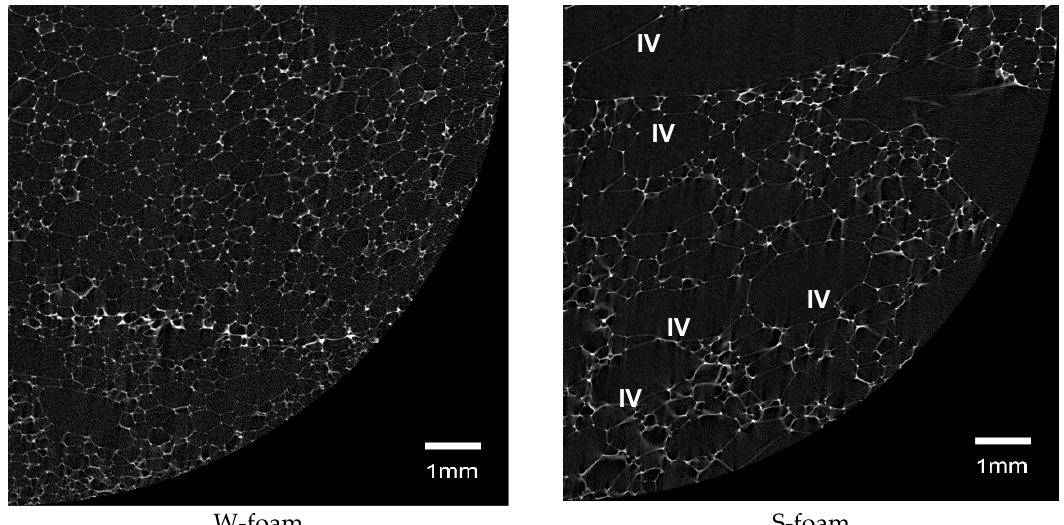
Figure 2. The example of horizontal (xy-plane) two-dimensional (2D) cross-sectional quarters of the reconstructed 3D cross-sectional image stacks, representing the PU W- and S-foam (BMP not resized, image pixel size 6.25 µ m). The 2D cross-sections are the last 3D stack sections, numbers 2100 and 5420, respectively. The white pixels in the reign of interest (ROI) represent the PU foam struts, the dark grey pixels—void space and the black—background. The symbol ‘IV’ denotes the population of largest pores, visible examples (cross-section) even with the naked eye in this image.